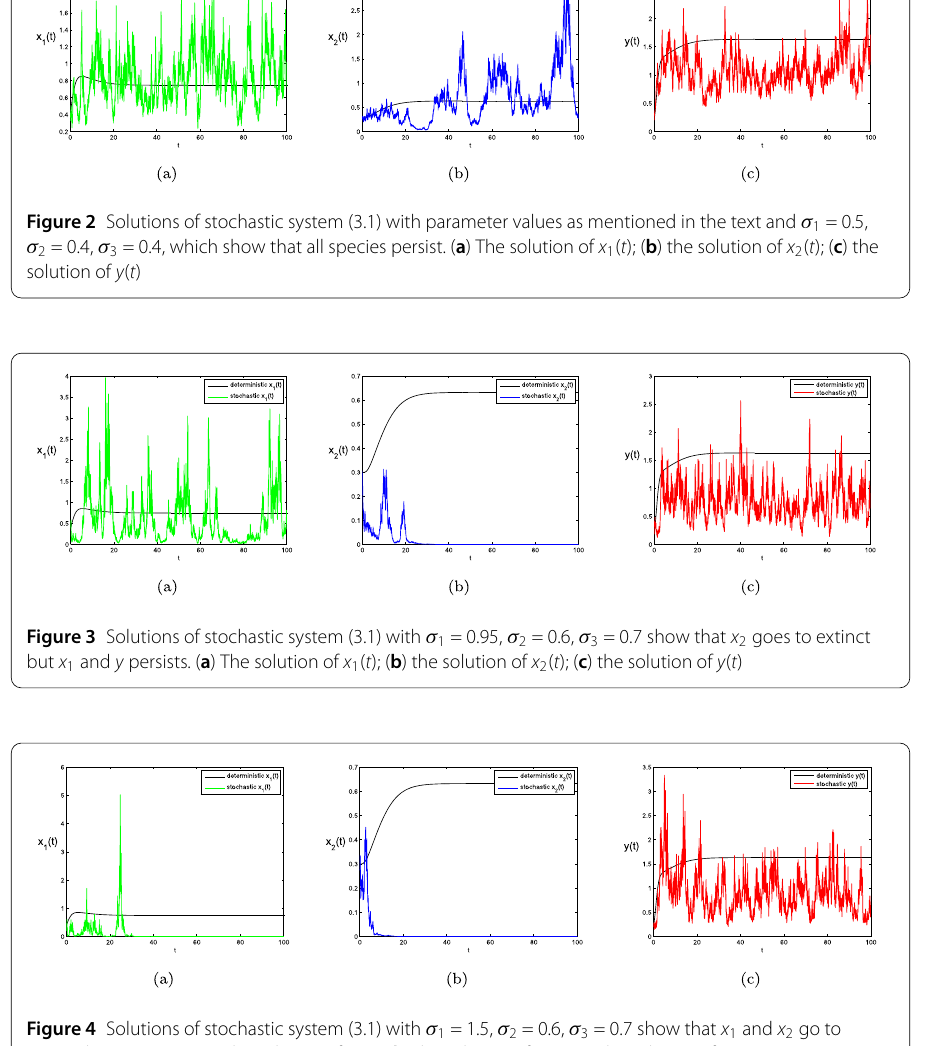
strengths of environmental forcing to σ 1 = 0.5, σ 2 = 0.4, σ 3 = 0.4, the population